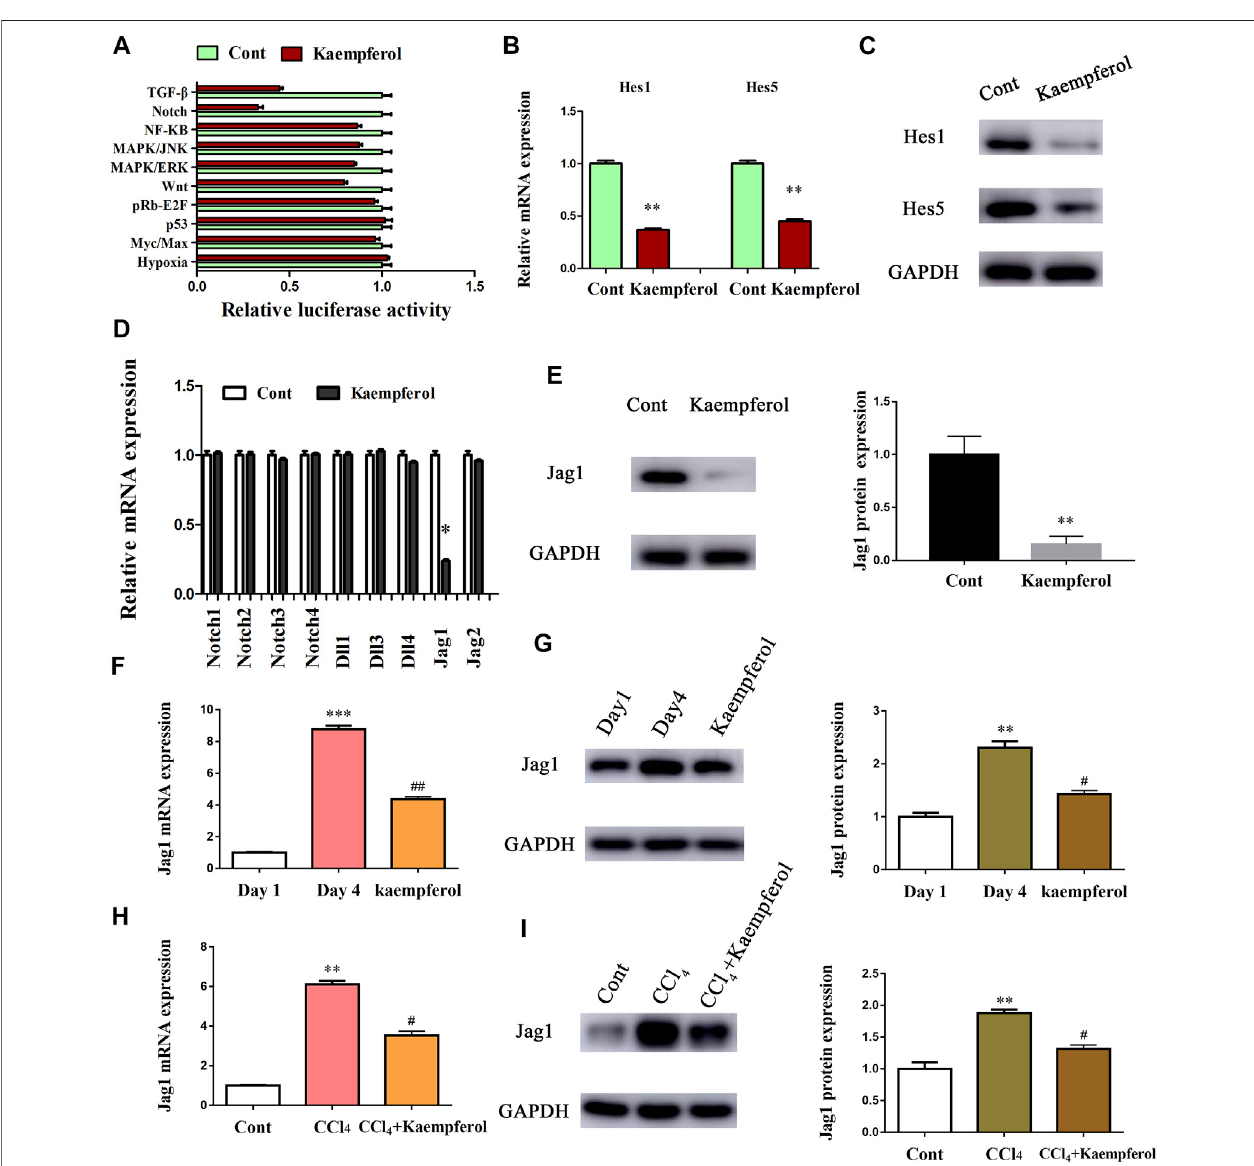
FIGURE 3 | Kaempferol inhibits HSC activation through Notch pathway. Primary 1-day-old HSCs were treated with 10 μ M kaempferol for 24 h. (A) Signaling pathway reporter array was performed to search for kaempferol-related pathways. mRNA (B) and protein (C) expressions of Hes1 and Hes5. Three experiments with similaroutcome. (D) mRNAexpressionsofNotchreceptorsandligands. (E) Jag1proteinlevelinkaempferol-treatedcells.mRNA (F) andprotein (G) expressionsofJag1 in primary HSCs during cell culture. mRNA (H) and protein (I) expressions ofJag1 in CCl 4 mice. ** p < 0.01, *** p < 0.01 compared with the control. # p < 0.05, # # p < 0.01 compared with the Day4 or CCl 4